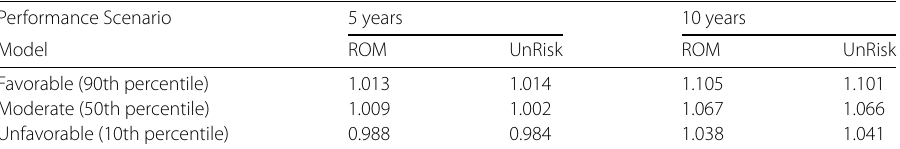
Table 6 Results for a floater with cap and floor Performance